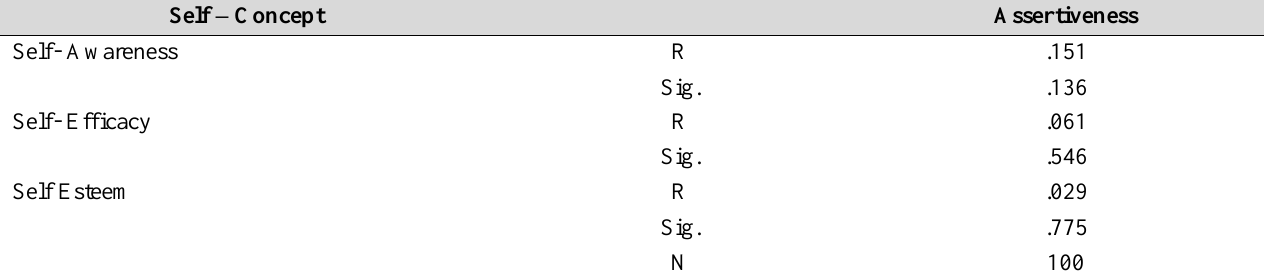
Table 4 revealed the Level of assertiveness on self-concept of teenage mothers in Kibera, Nairobi.